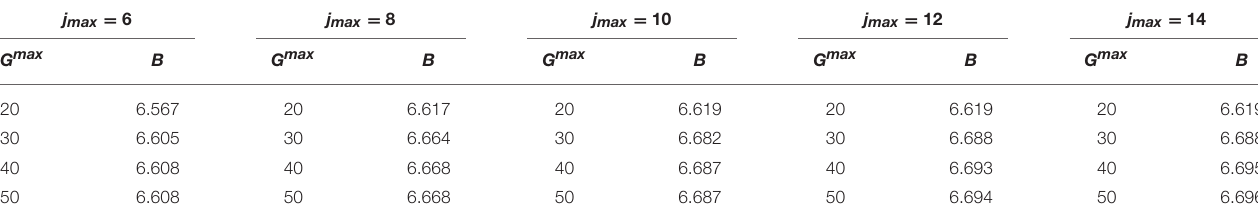
TABLE 4 | Same as Table 2 but for the Afnan-Tang potential model [13].